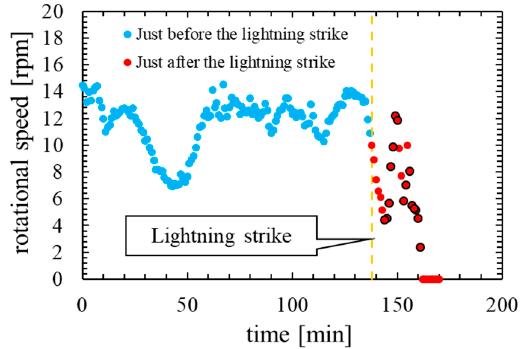
Figure 3. Time characteristic of rotational speed in normal operation: ( a ) rotational speed on normal operation; ( b ) rotational speed on normal operation (partial expansion).